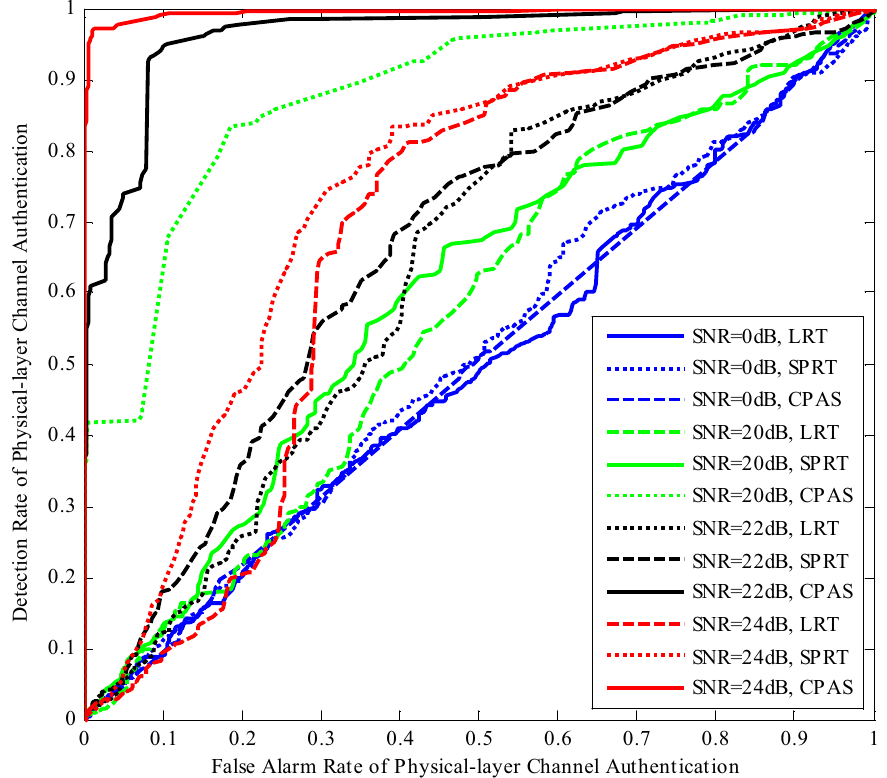
Figure 11. Comparisons of detection rate and false alarm rate under different